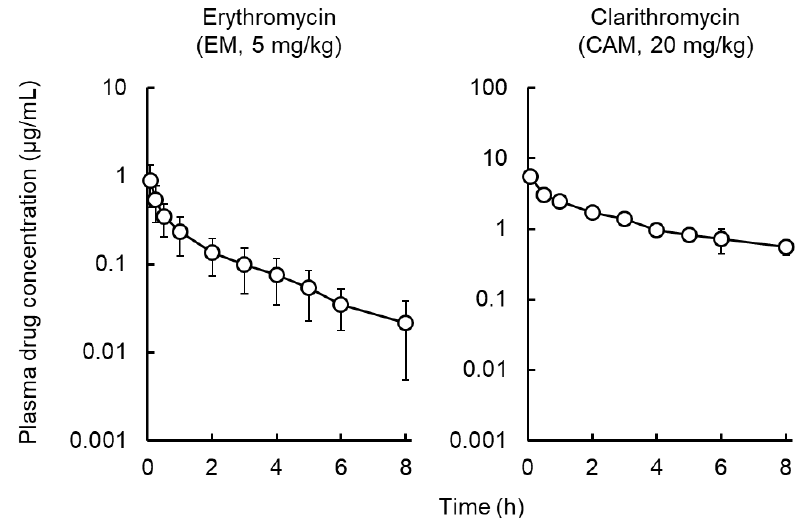
Figure 1. Mean plasma concentration profiles of erythromycin (EM) and clarithromycin (CAM) after intravenous administration of EM (5 mg / kg) or CAM (20 mg / kg) to rats. Each symbol with a bar represents the mean ± S.D. for five rats.